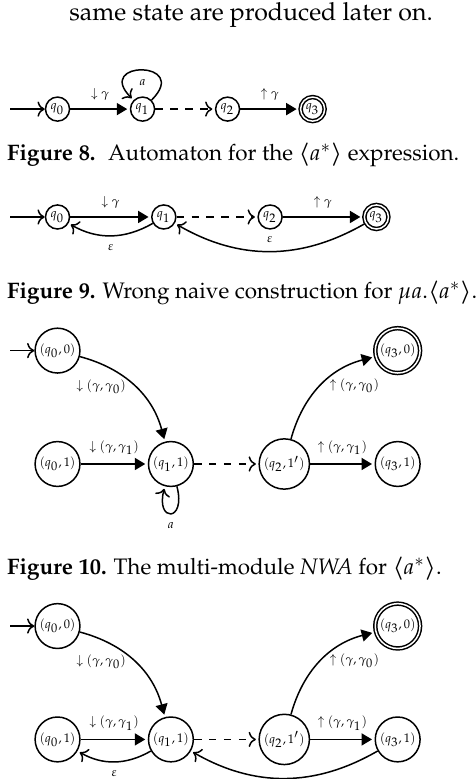
. a ∗ (cid:104) (cid:105)